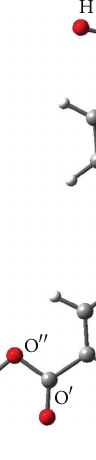
Figure 1: Optimized geometry of the dye, in its protonated form, as acid chrome yellow (H 3 ACY), calculated at DFT/B3LYP/6-31G(d) level. The atom labeling is used in Table 1. Table 1: Proton affinities (PA) of H3ACY in water solution using the PCM approach [42,